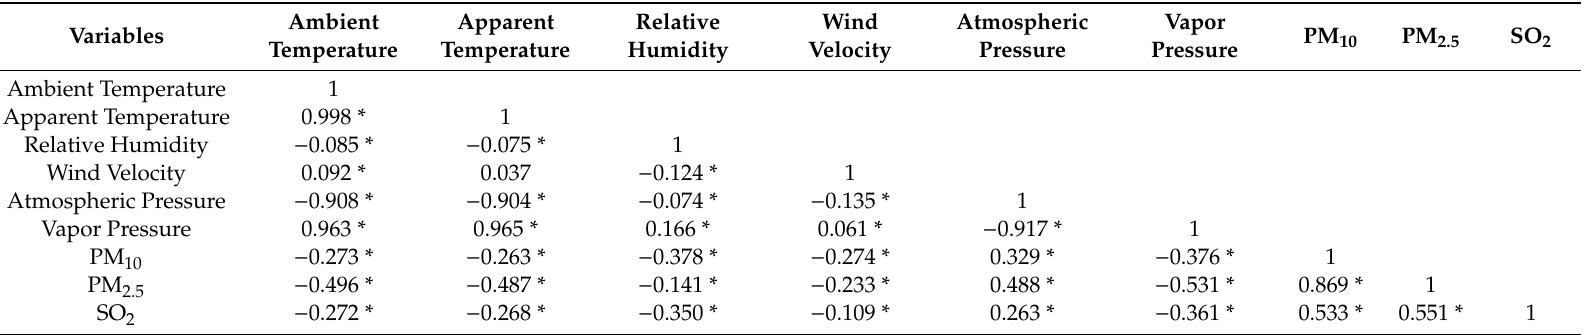
Table 2. Spearman correlation between ambient temperature, apparent temperature, relative humidity, wind velocity, atmospheric pressure, vapor pressure, SO 2 , PM 10 , and PM 2.5